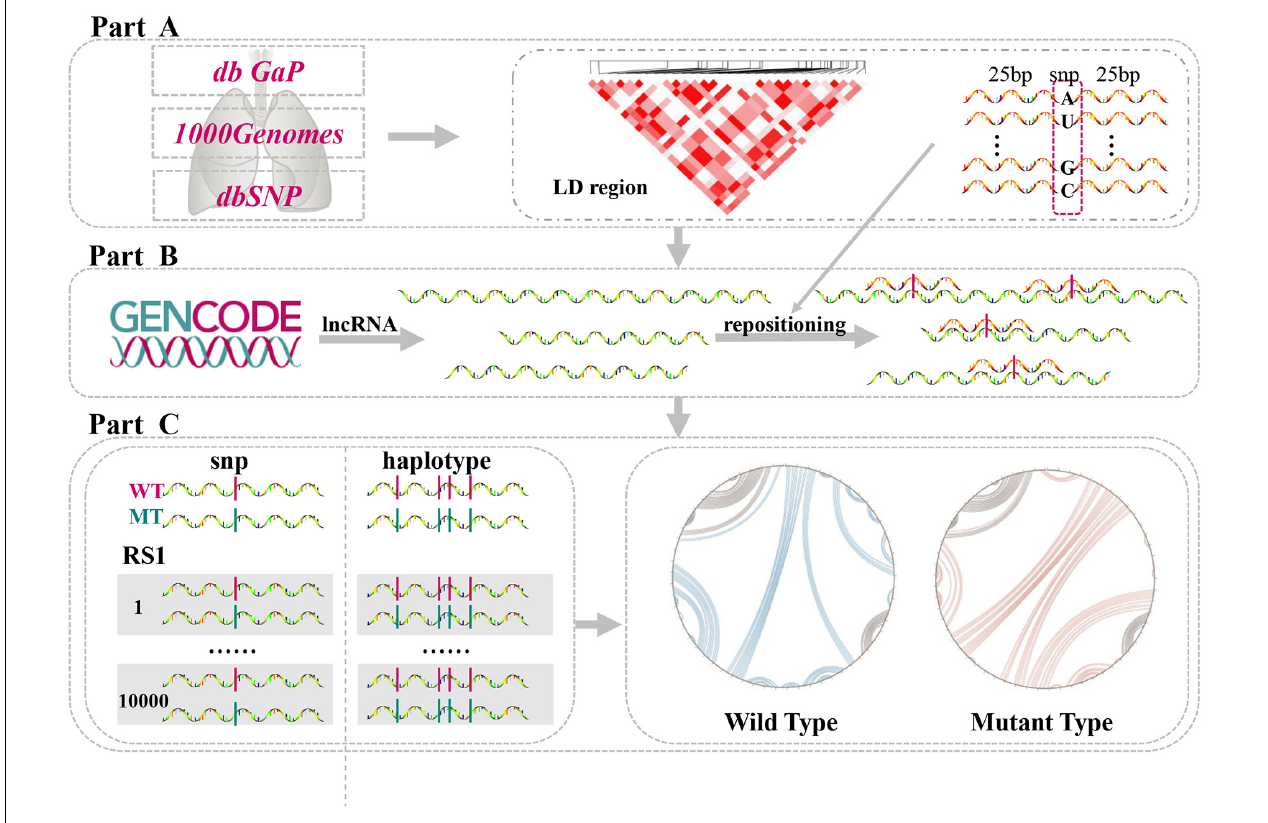
FIGURE 1 | Comprehensive analysis of lncRNA structural heterogeneity generated by linkages-disequilibrium SNPs (LD SNPs). (A) Sources of data of lung-disease-associated SNPs and their LD SNPs. (B) Information on lncRNA transcripts and positions of LD SNPs within lncRNAs. (C) Perturbations to evaluate the differences between WT and MT